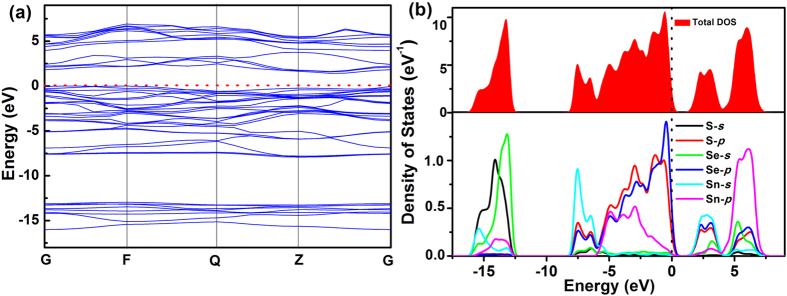
(a) Calculated band structure of SnS0.44Se1.56 alloy. (b) The total and partial density of states of SnS0.44Se1.56.